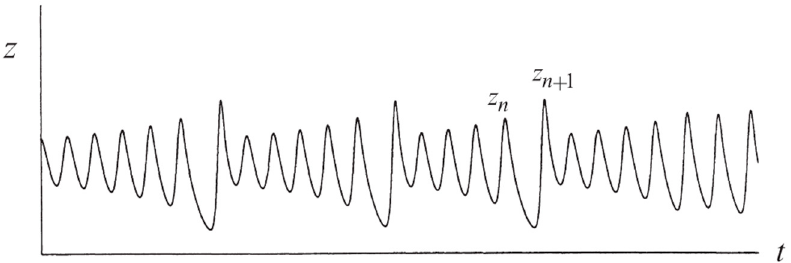
Figure 3. Lorenz focused on the connection of two adjacent local maxima in the system response.